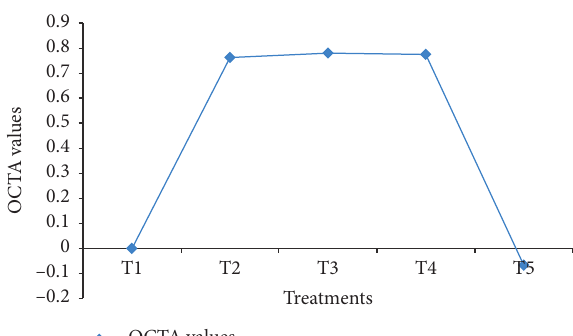
Figure 6: OCTA trend for AOL (Area of